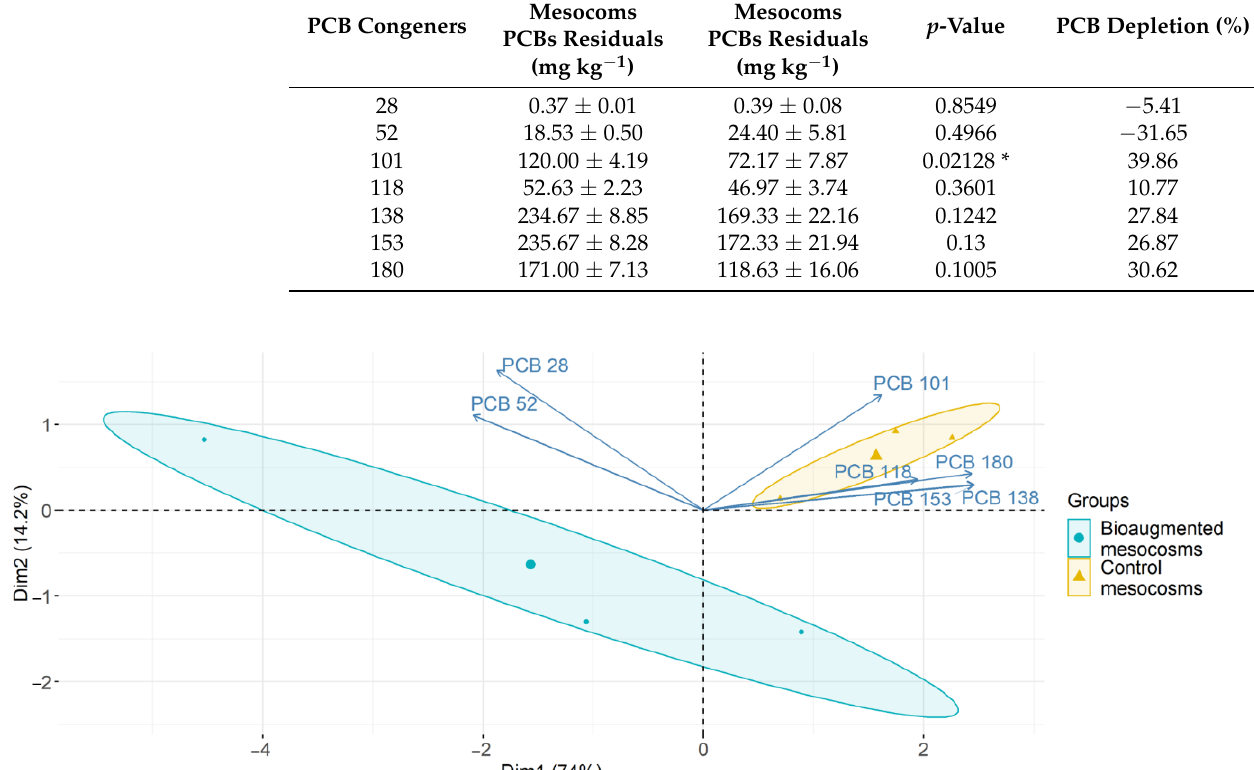
Figure 2. Principal component analysis (PCA) of PCB concentrations in control and bioaugmented soil after a three-month- treatment. The analyses are based on the concentration of seven PCB congeners in control mesocosms (triangle) and bioaugmented mesocosms (circles).